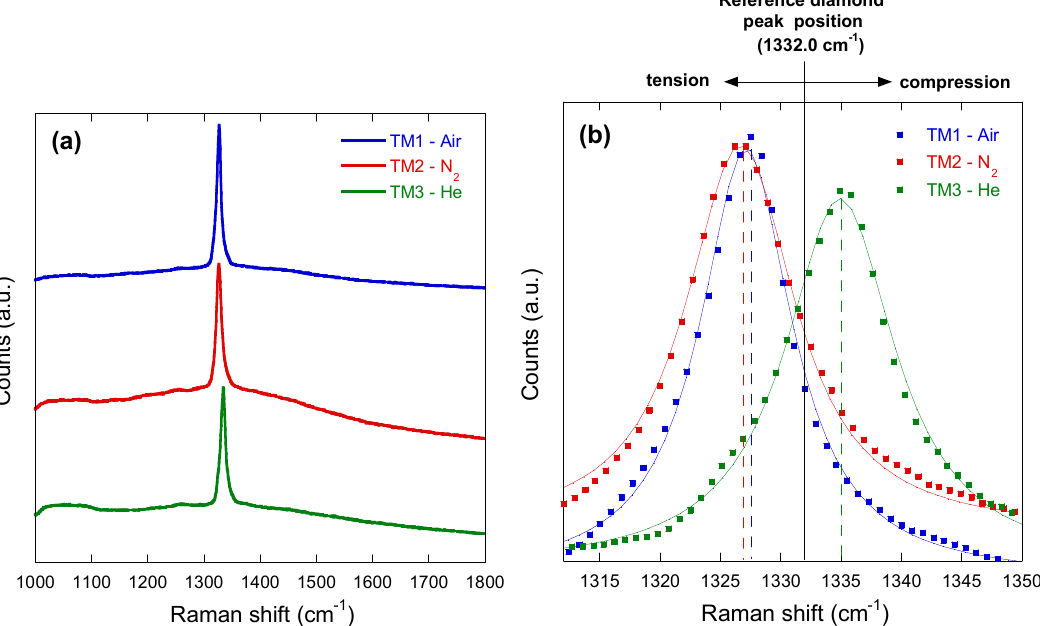
Figure 4. ( a ) Full Raman spectra of the three black diamond films fabricated under different gas environments. Spectra were vertically shifted for the sake of clarity; ( b ) Details of the three spectra shown in Figure 4a in the Raman shift range around the reference diamond peak position at 1332.0 cm − 1 ; square dots represents raw data, solid lines indicate the Voigt functions used to fit the peak profiles, whereas dashed lines indicate the diamond peak position of the three different black diamond films.